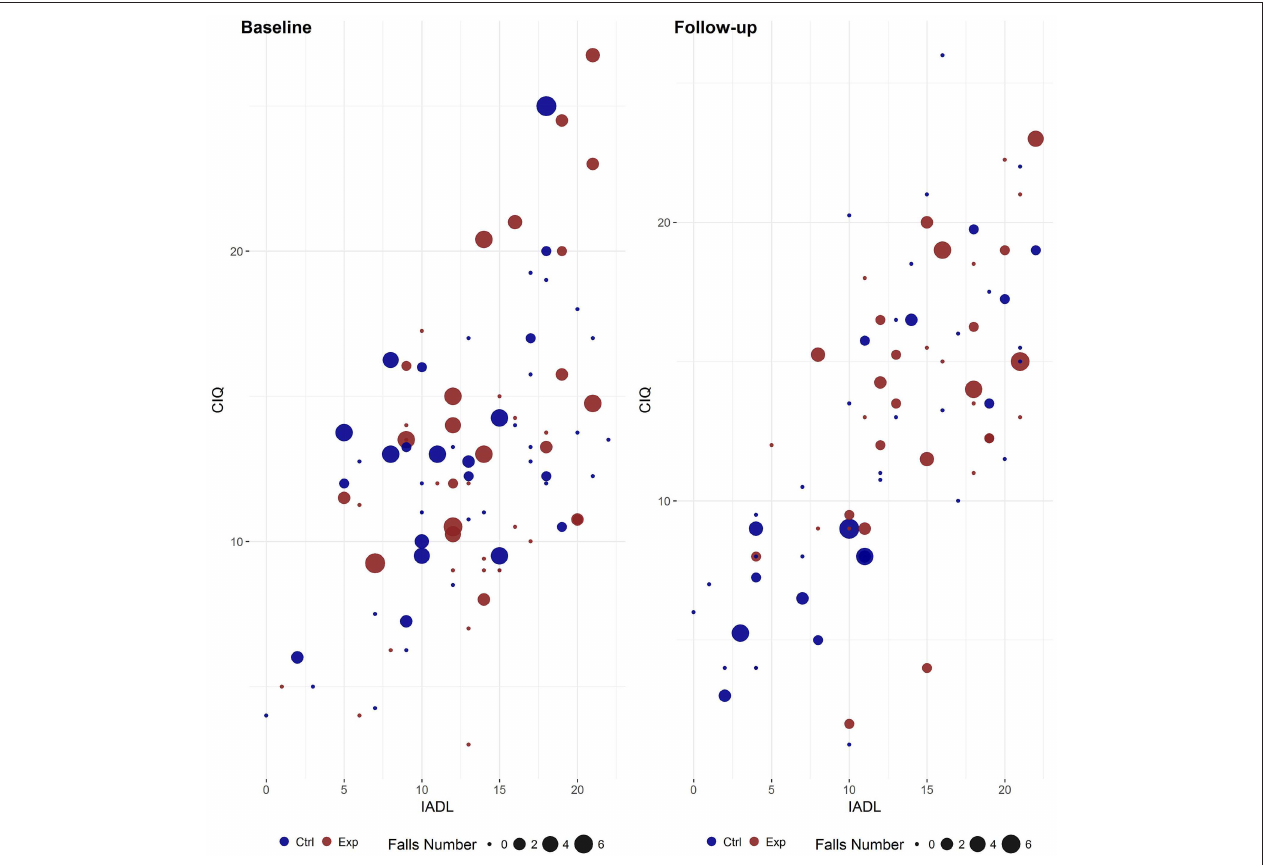
FIGURE 3 | Relationship between participation, activity of daily living and number of falls in education and control group at baseline and during follow-up. IADL, Instrumental Activity of Daily Living; CIQ, Community Integration Questionnaire; Exp, Experimental Group; Ctrl, Control